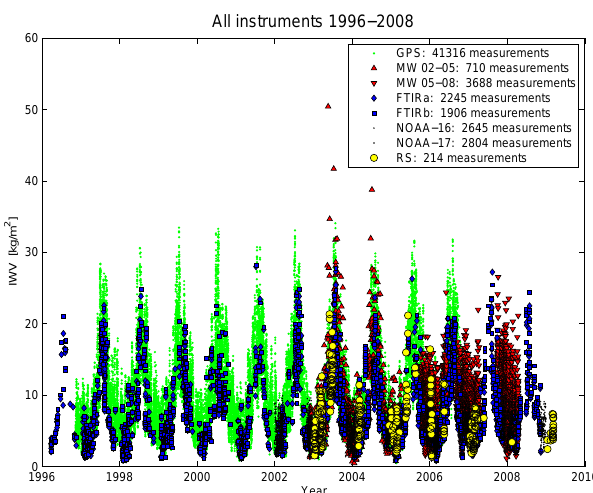
Fig. 2. Overview time series of all integrated water vapour (IWV) data used in this study. Only the ERA-Interim data are not shown, since they would make the figure too